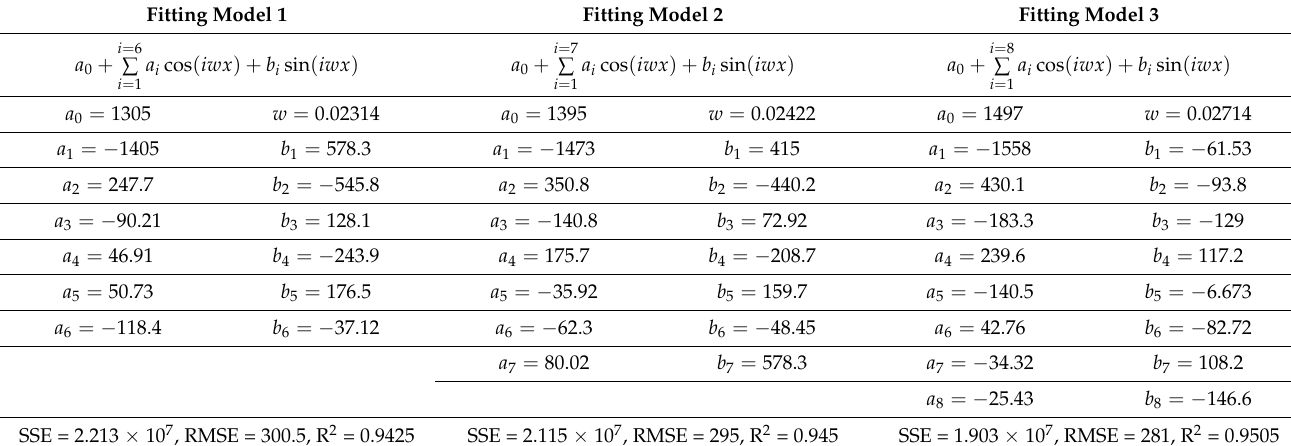
Table 2. Used mathematical fitting models for Saudi Arabia data with optimized coefficients. Fitting Model 1